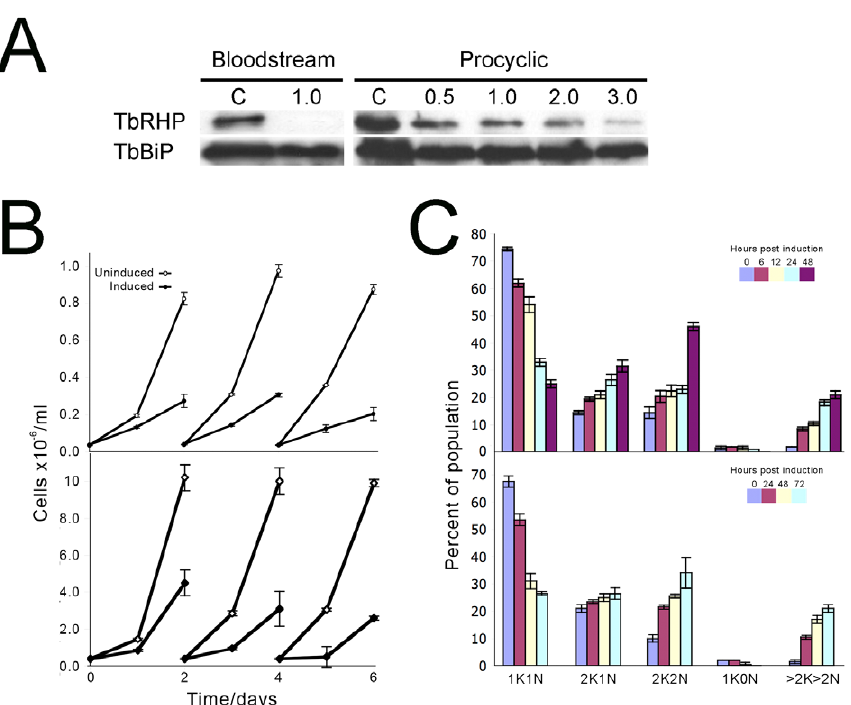
Figure 3. TbRHP is required for normal progression though the cell cycle. (A) Loss of TbRHP protein expression by RNAi. BSF and PCF cells were subjected to RNAi for TbRHP. Aliquots of culture were withdrawn at intervals and the abundance of TbRHP determined by Western blotting using affinity-purified rabbit polyclonal anti-TbRHP antibody followed by ECL detection. Equivalence of loading was determined by reprobing the membranes with antibody to trypanosome BiP (TbBiP). Numbers above the lanes indicate time, in days, while C indicates uninduced cells, equivalent to time zero. (B) Sawtooth growth curves for BSF (top) and PCF (bottom) cultures induced for RNAi against TbRHP. In both cases a growth defect is manifested within 24 hours, and is pronounced after two days. Filled symbols; induced cultures, open symbols; uninduced cultures. (C) Cell cycle progression is perturbed in both BSF and PCF cells by TbRHP RNAi. Logarithmic cultures of trypanosomes containing the relevant p2T7 N TbRHP RNAi plasmid were induced and propagated as in (A). At the indicated times aliquots were withdrawn and the cells fixed, stained for DNA with DAPI and analyzed by fluorescence microscopy. Individual cells were scored for the number of nucleli (N) or kinetoplasts (K). At least 400 cells were analyzed at each time point and the analysis performed in duplicate. Error bars indicate the range and the values plotted are the